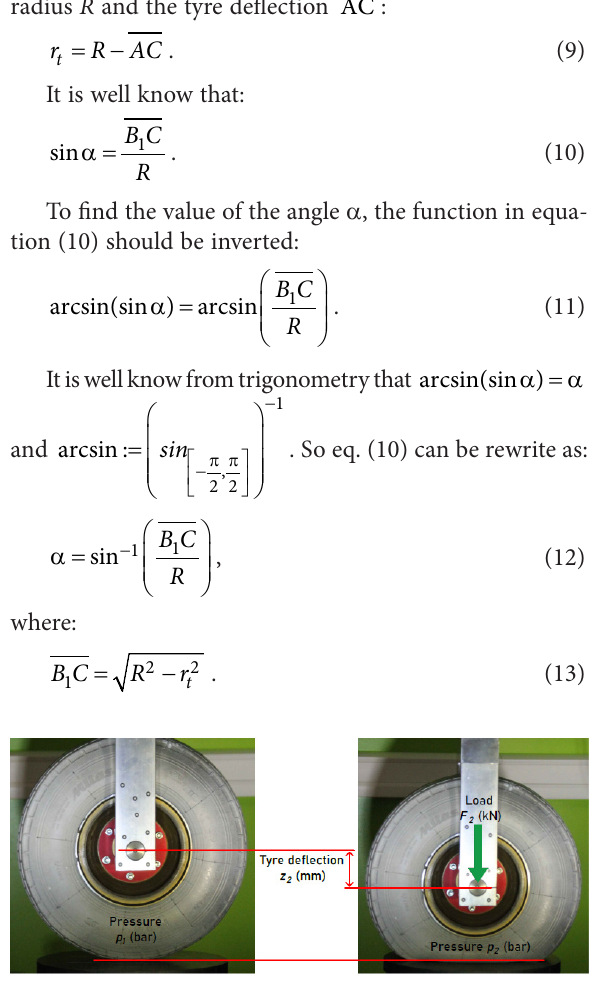
Figure 4. Quantities measured in the unloaded (left) and loaded (right) tyre static load